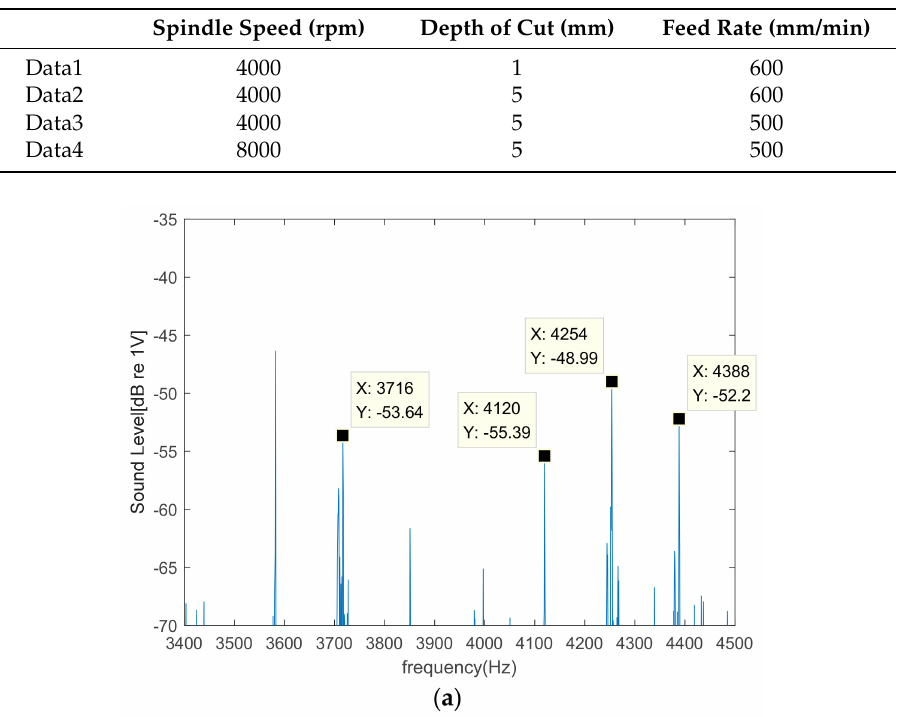
Table 1. The settings of CNC milling